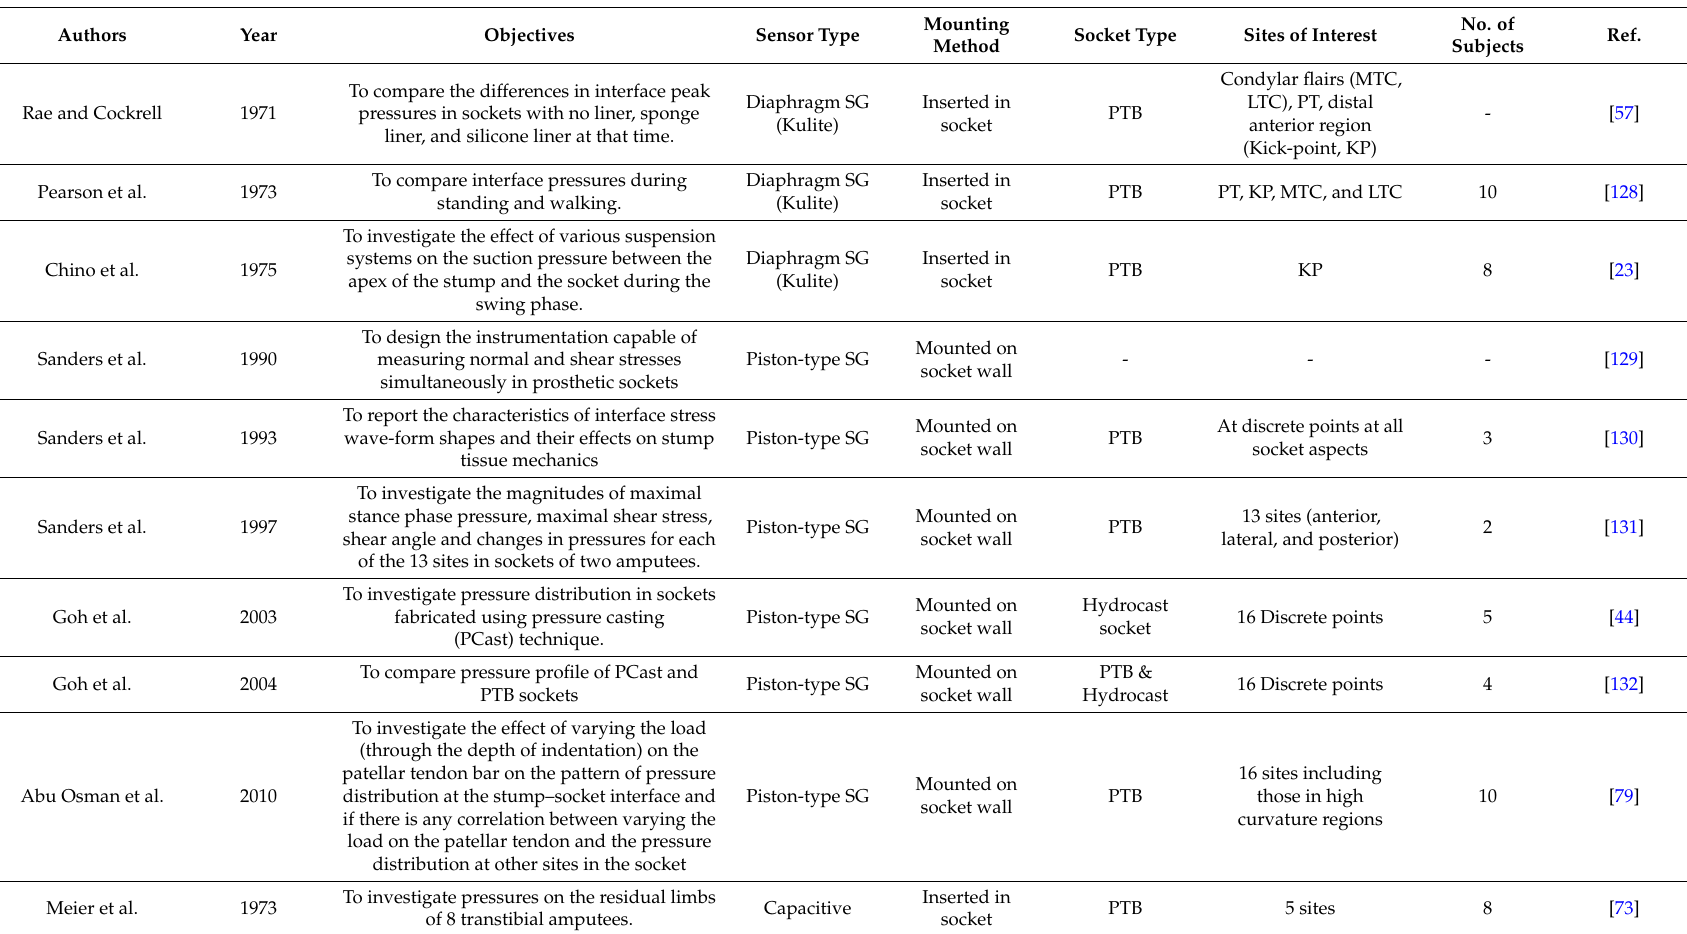
Table 2. Pressure transducers used within transtibial sockets based on different transduction